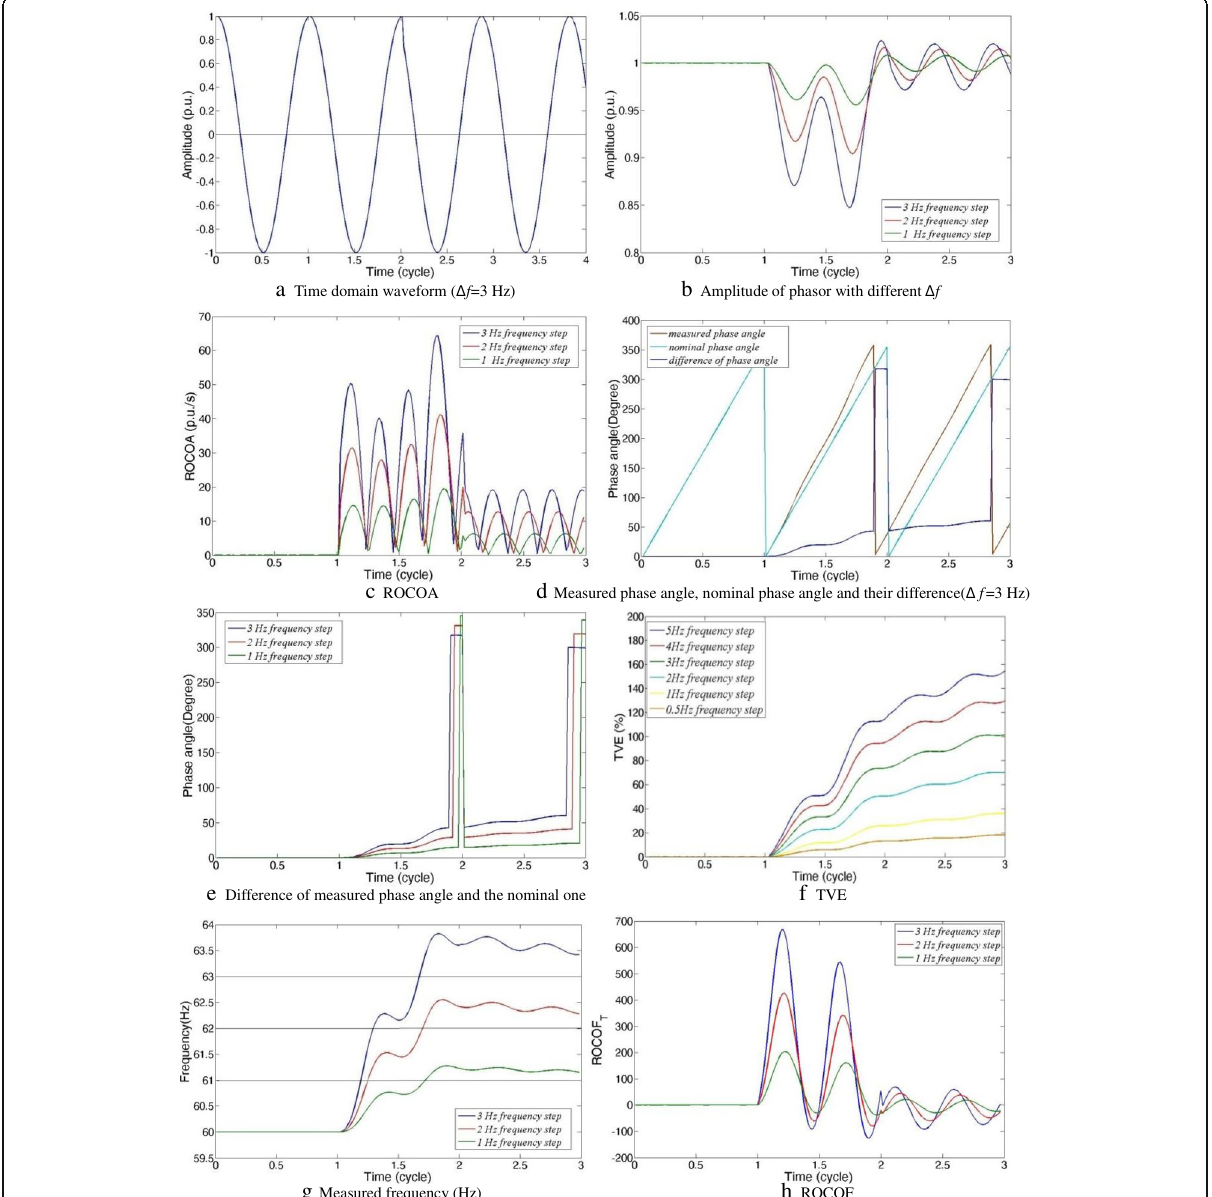
Fig. 8 Frequency step change examples (step change occurs at the beginning of the second cycle; A = 1 p.u., f 0 = 60 Hz, φ 0 =